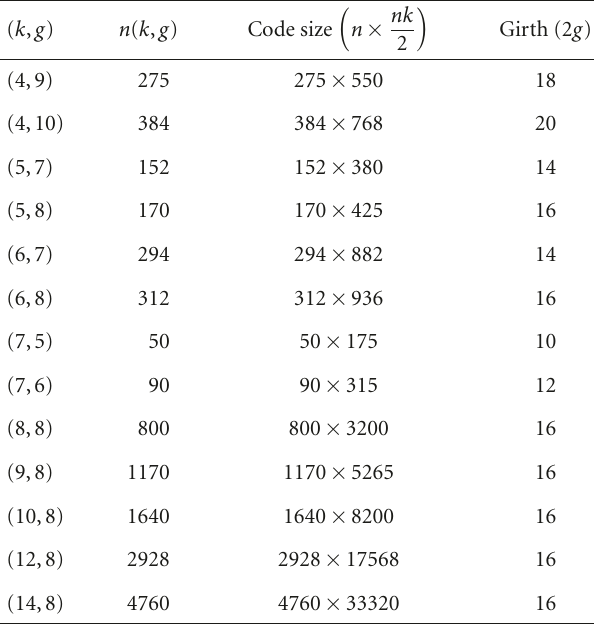
Table 2: Some of known cages’ graphs with vertex degree higher than three.